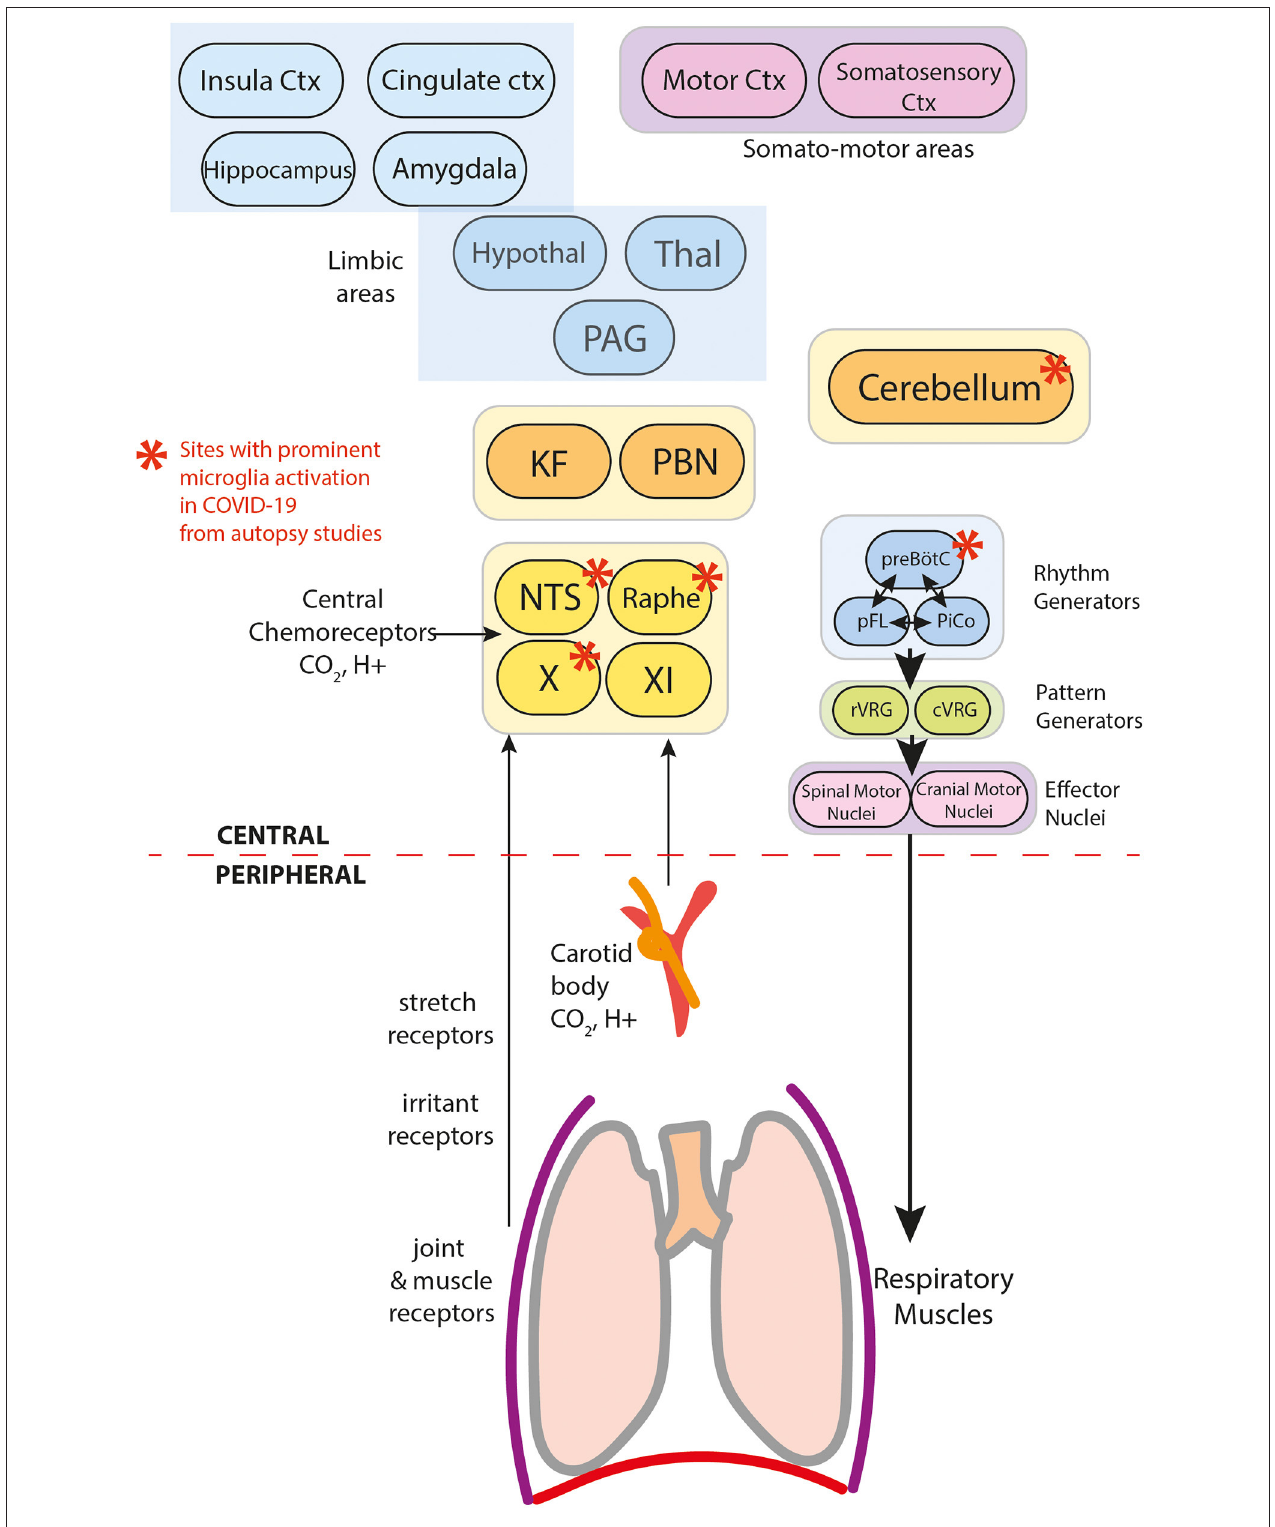
FIGURE 3 | Components of breathing control in the context of